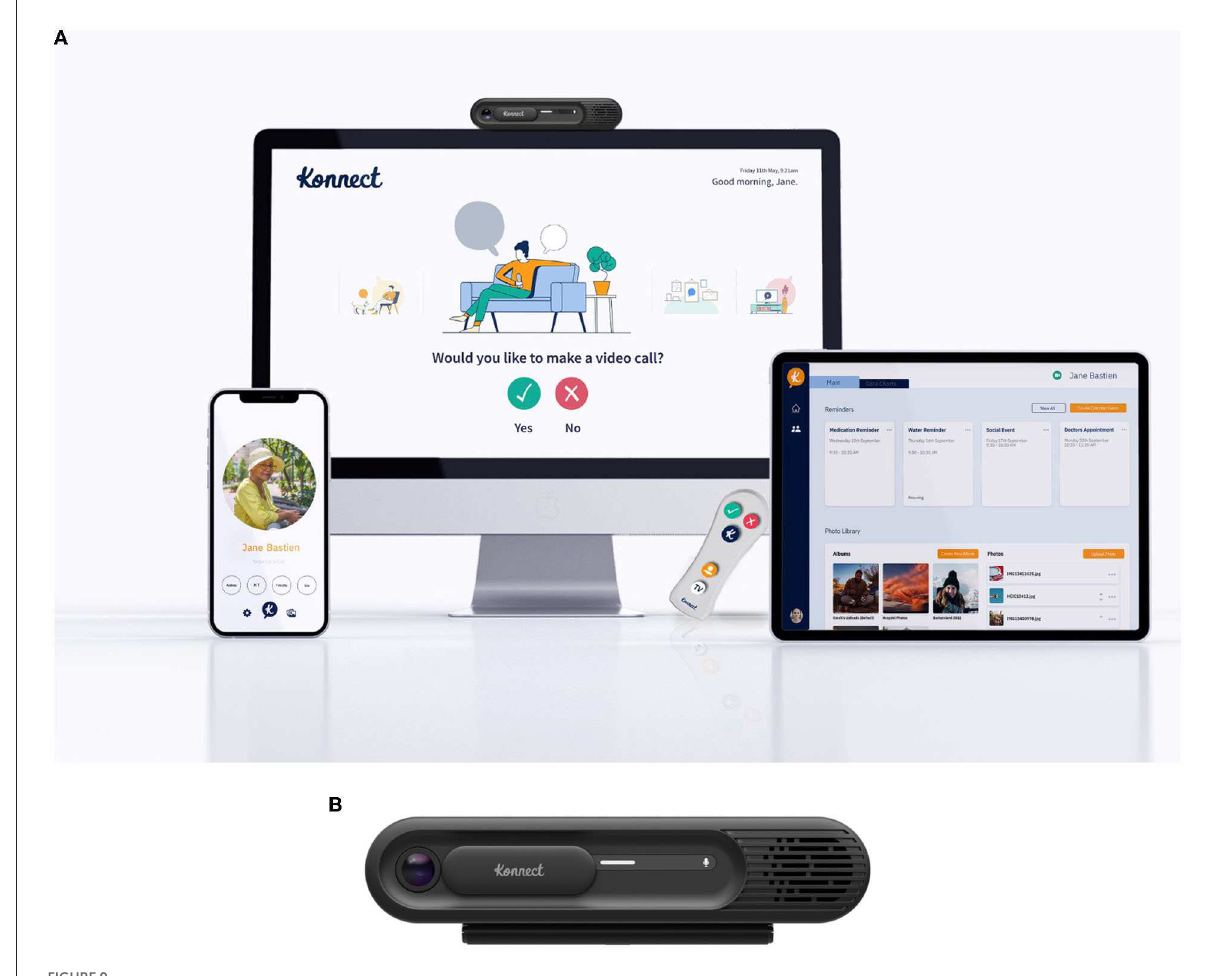
FIGURE9 (A, B) Kraydel Konnect current